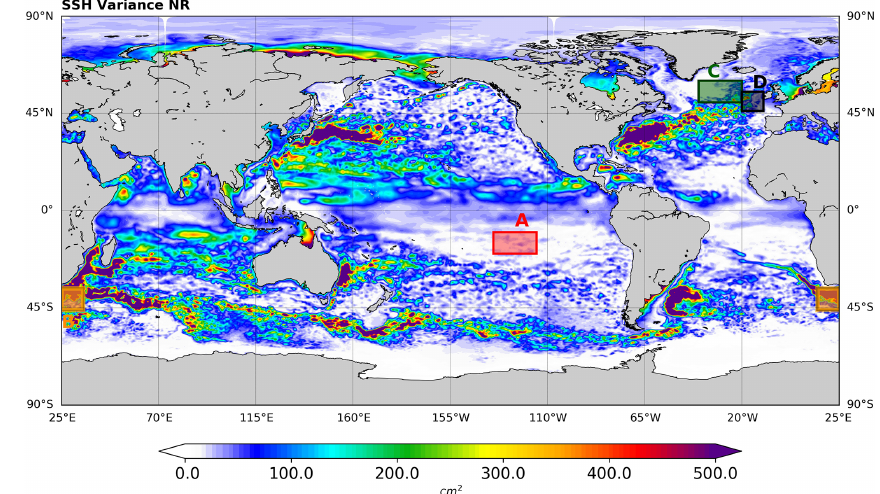
Figure 3. SSH variance (in cm 2 ) in the NR over the period from February to December 2015. The boxes denote the rectangular sub-regions for which wavenumber spectra and coherence analyses were performed.